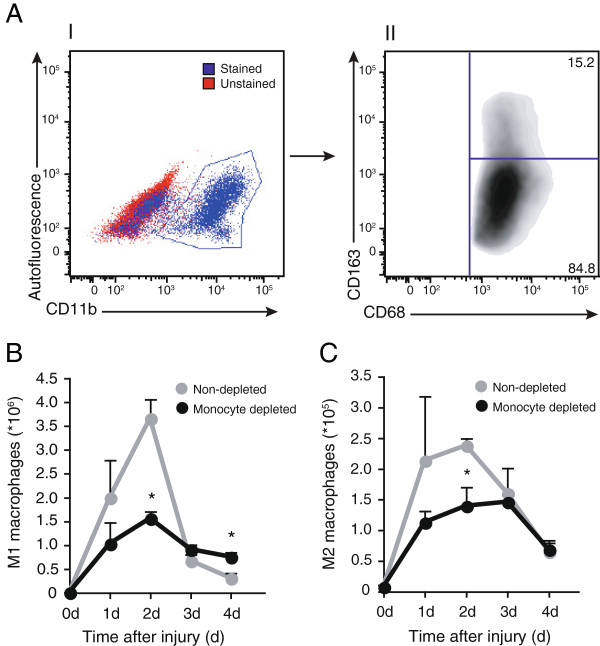
Numbers of M1 and M2 macrophages in TA muscle are modified by blood monocyte depletion. Rats were treated once a day with intravenous injection of liposome-encapsulated clodronate starting 24 h prior to injury until euthanasia at 1, 2, 3 and 4 d post-injury, for analysis of M1 and M2 macrophage accumulation into injured muscle. (A) Gating strategy (at 3 d post-injury) in single cell suspensions from skeletal muscles was based on omission of primary antibody for CD11b, and on isotype control stainings for CD68 and CD163 to identify M1 (CD163-) and M2 (CD163+) subsets. Liposome-encapsulated clodronate induced a significant decrease in accumulation of M1 (B) and M2 (C) macrophages at 2 d post-injury and a significant increase in M1 macrophage number at 4 d post-injury. *Significantly different from non-depleted groups, Student’s t-test, p < 0.05. n = at least 3, for all the time points and conditions evaluated.